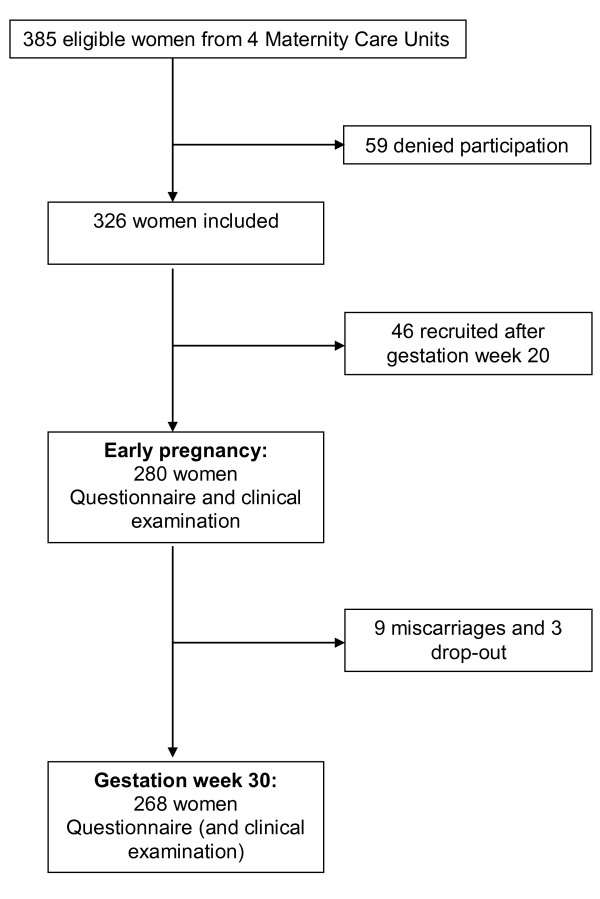
The study sample.